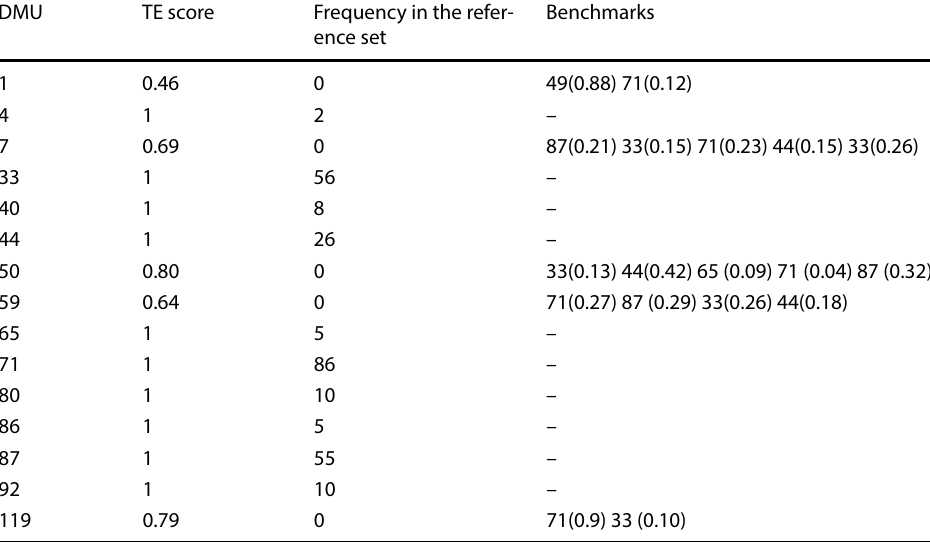
Table 6 Technical efficiency